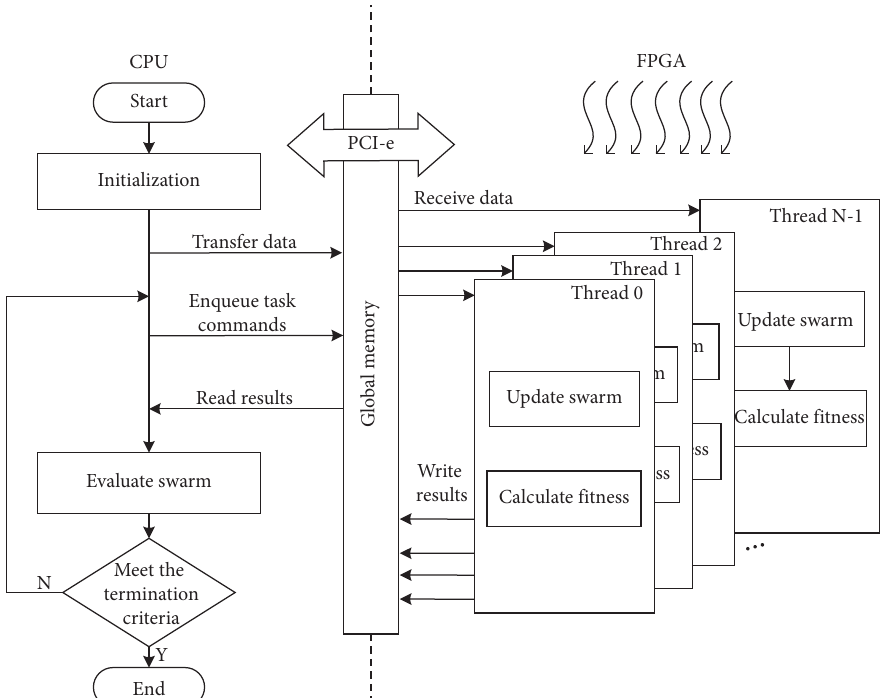
Figure 3: Framework of the partial parallel model-based PWOA